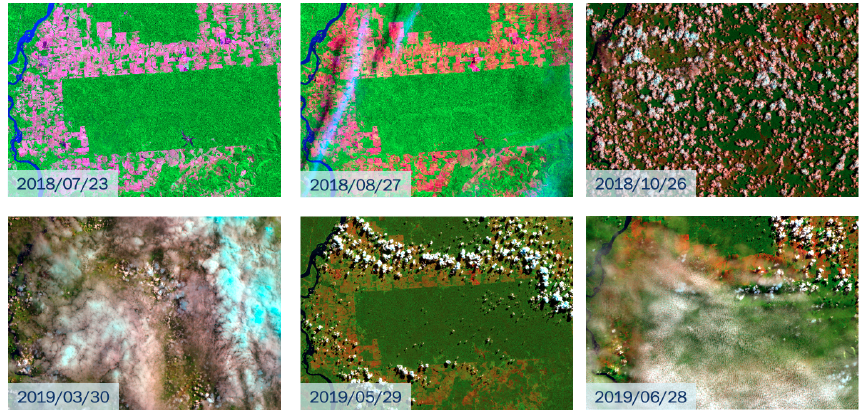
Figure 2. Sentinel-2 image colour composites for tile 20LKP on different dates (source: